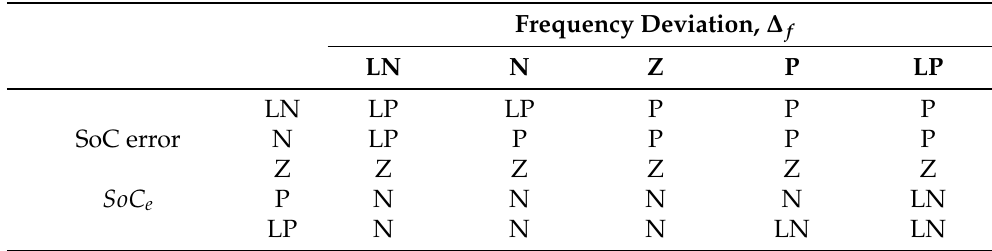
Table 2. Rule base of the FLC controller to determine the power reference considering the linguistic variables of frequency deviation and state-of-charge